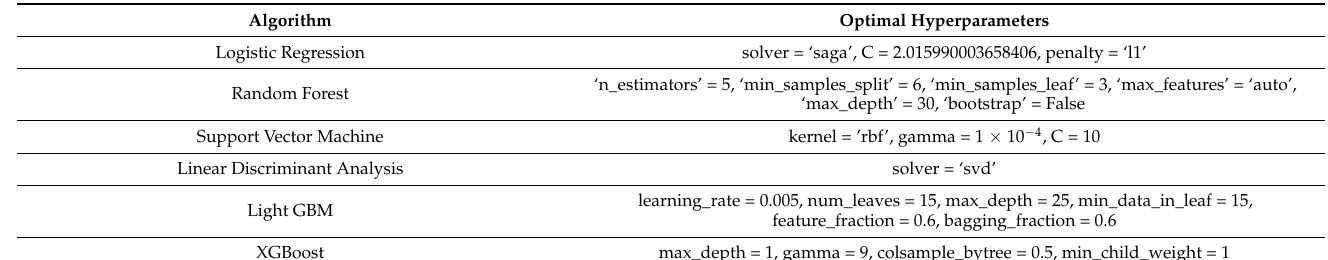
Table 5. Hyperparameters of machine learning algorithms in predicting the TMB group.